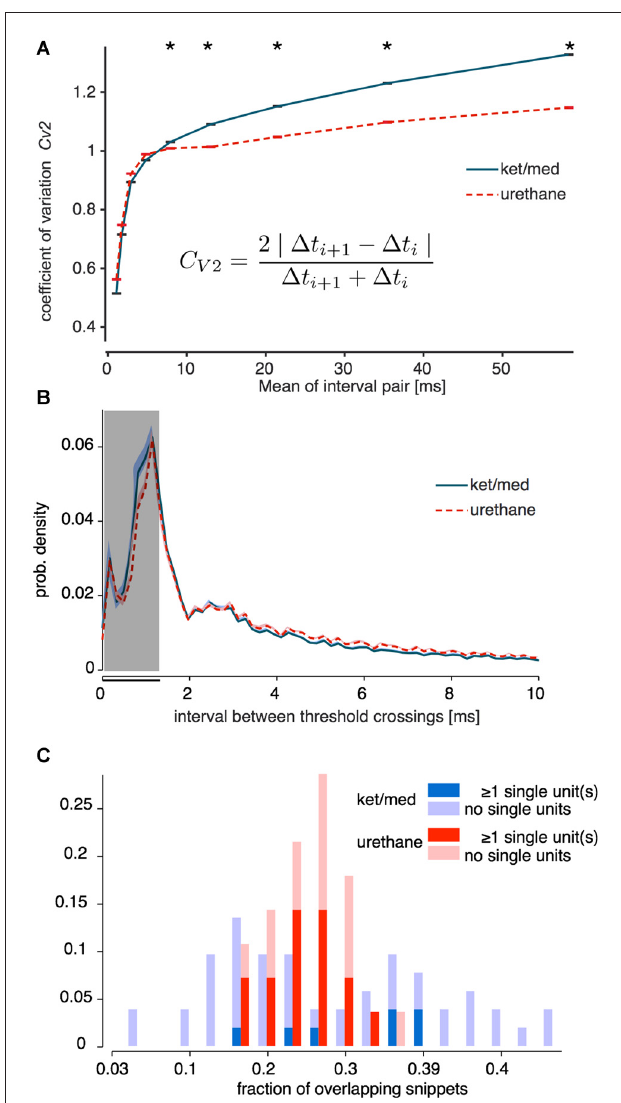
FIGURE 2 | Overlap of spike snippets. In (A) , the C V2 (see inset) is plotted as measure of the irregularity (“burstiness”) of the inter-event intervals (IEIs) of the snippets used for sorting under ketamine/medetomidine (ket/med, blue line) and urethane (dotted red line) anesthesia. Error bars depict standard error of the mean (SEM) on the vertical axis; SEM is in the range of the thickness of horizontal cap lines. Asterisks mark data points for which the C V2 under ketamine is significantly larger than under urethane (one-sided Wilcoxon rank-sum test, p < 0.001). (B) Mean IEI distribution for all recordings of the unsorted events (blue/red shaded areas: SEM). The gray area indicates the criterion for minimal IEIs used to classify sorting of a unit as successful ( Figure 1B ). In (C) the distribution of the fraction of overlapping snippets for urethane (red) and ket/med (blue) is displayed. Successful and unsuccessful sorts are plotted separately in different dark and light shades, respectively (Kolmogorov-Smirnov test for difference in distributions: ket/med, p = 0.15, urethane, p =